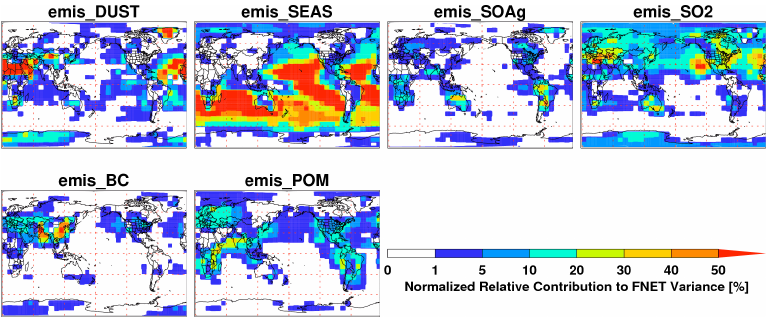
Figure 12 Global spatial distribution of normalized percentage of FNET variance in 1130 Fig. 12. Global spatial distribution of normalized percentage of FNET variance in response to the perturbation of six emission parameters response to the perturbation of six emission parameters predicted by the GLM. 1131 predicted by the 1132